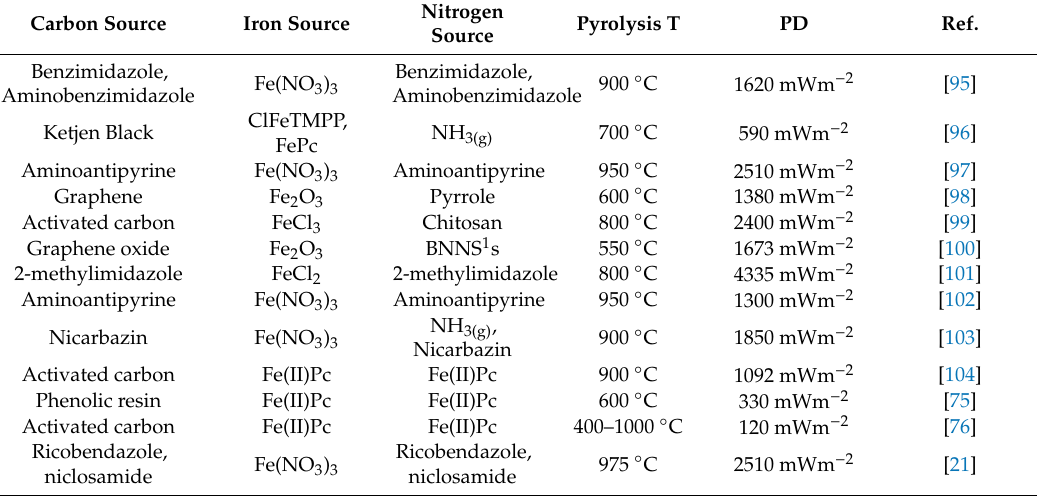
Table 2. Summary of the microbial fuel cell (MFC) performance (power density, PD) of M-N-C catalysts obtained by di ff erent sources of carbon, iron, and nitrogen, and di ff erent pyrolysis